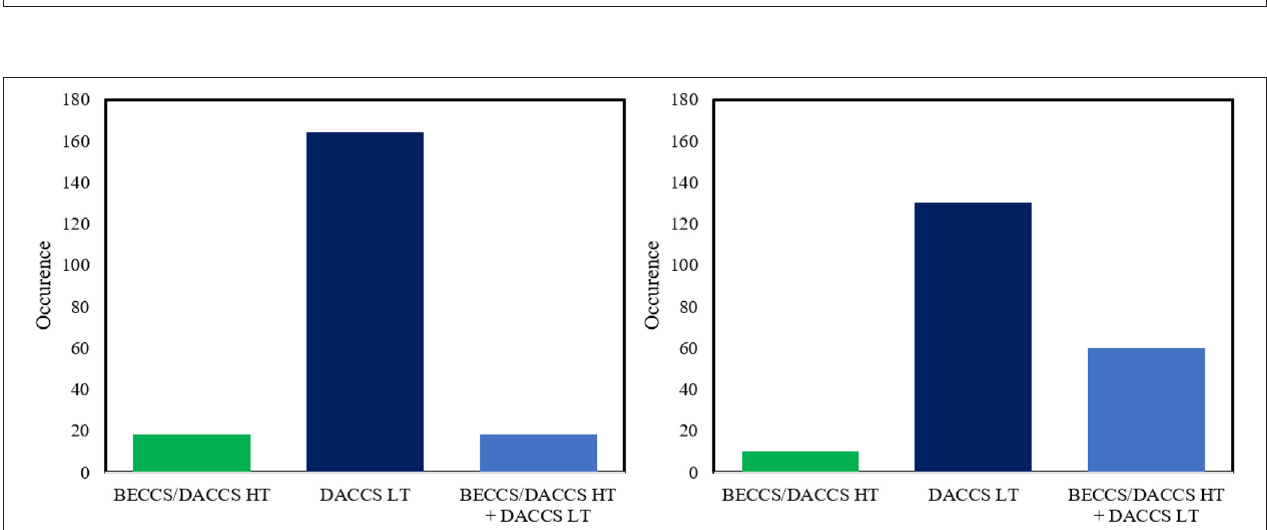
FIGURE 6 | Occurrence of different NETs or combination of them in Monte Carlo analysis (200 runs) in the regions ES3 (sunny) to the left and IE (windy) to the right respectively.